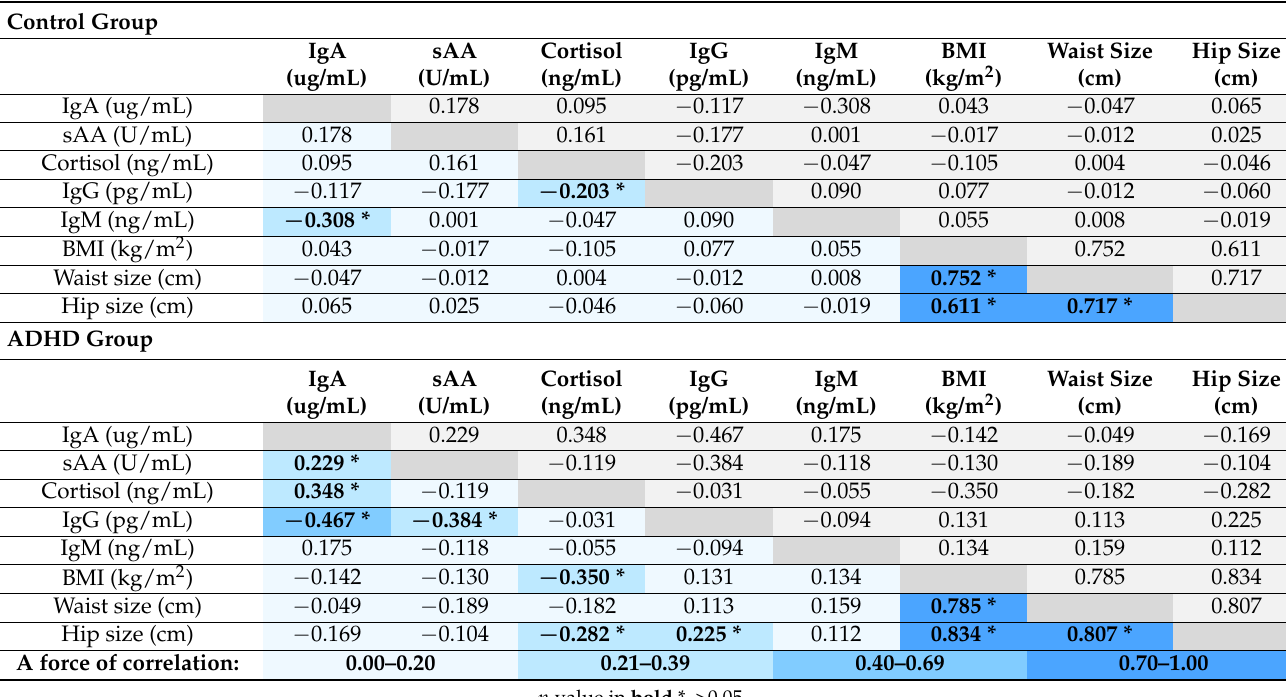
Table 3. Spearman’s analysis of correlations (cortisol, alpha-amylase, IgA, IgG, IgM, BMI, and waist and hip sizes) between the ADHD and control